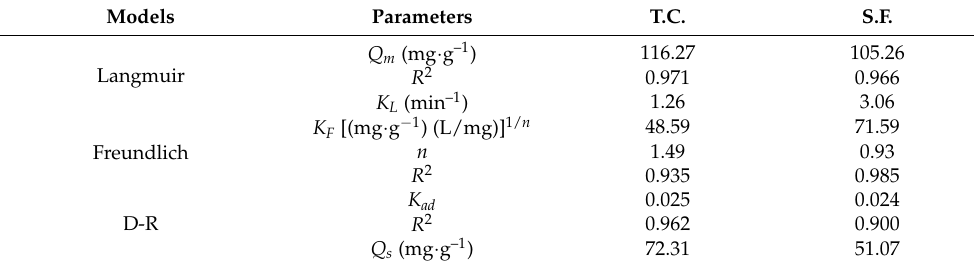
Table 2. Isotherm models for TC and SF adsorption from aqueous